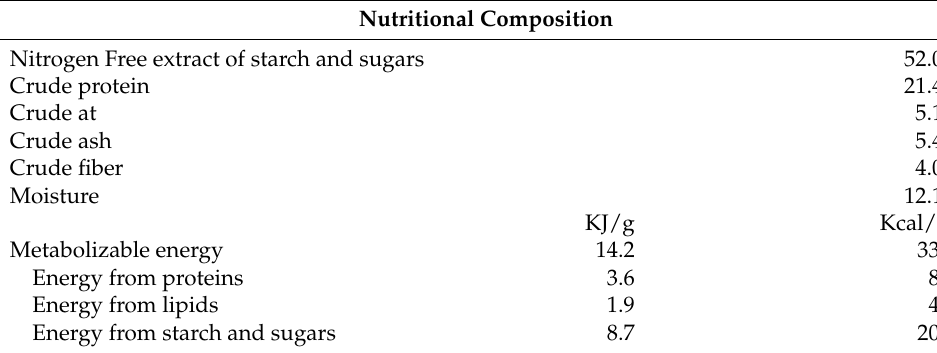
Table 3. Composition of the normal diet and energy contributions of ingredients. Nutritional